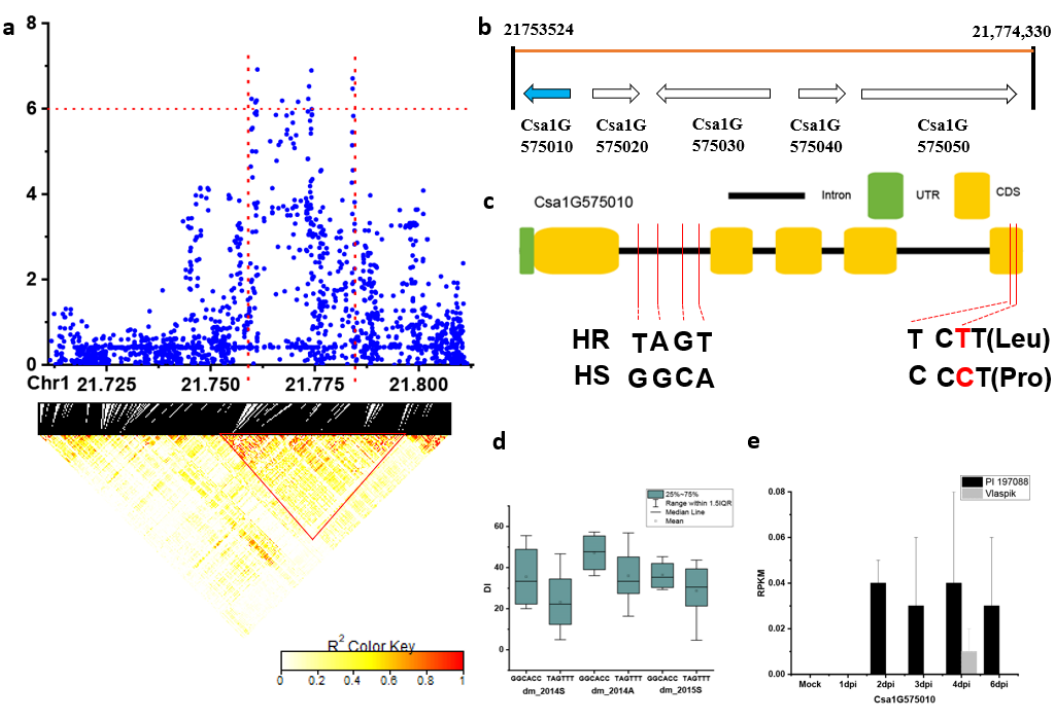
Figure 7. Identification of the causal gene for the locus dmG1.4 . ( a ) Local Manhattan plot (top) and LD heatmap (bottom) surrounding the peak of dmG1.4 ; ( b ) five genes were predicted in the LD block region; ( c ) SNP variation of the candidate gene Csa1G575010 between the highly susceptible (HS) and highly resistant (HR) lines (see Supplementary File 5). The SNP in red color is located in the CDS resulting in amino acid variation. ( d ) Disease index (DI) comparison between haplotypes of the HS and HR lines (see Supplementary File 3); ( e ) RPKM of the candidate gene Csa1G575010 based on the transcriptome of PRJNA285071 (data obtained from http://cucurbitgenomics.org/rnaseq/cu/19) [24]. For the locus dmG5.2 , the 50-kb region around the peak SNPs was further analyzed and a candidate region from 22,883 to 22,913 kb (~30kb) (Figure 8a) was estimated using pairwise LD